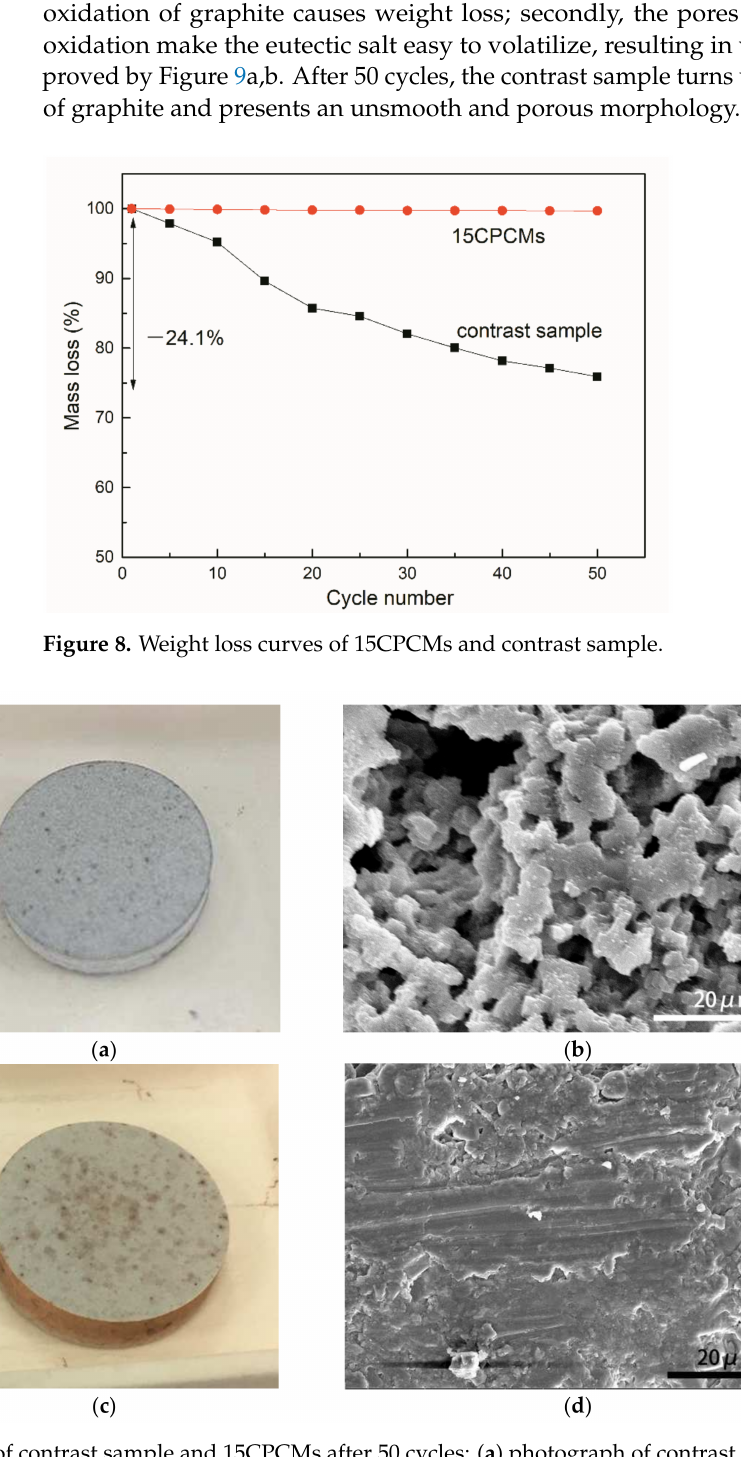
Figure 9. Morphology of contrast sample and 15CPCMs after 50 cycles: ( a ) photograph of contrast sample, ( b ) SEM image of contrast sample, ( c ) photograph of 15CPCMs, ( d ) SEM image of